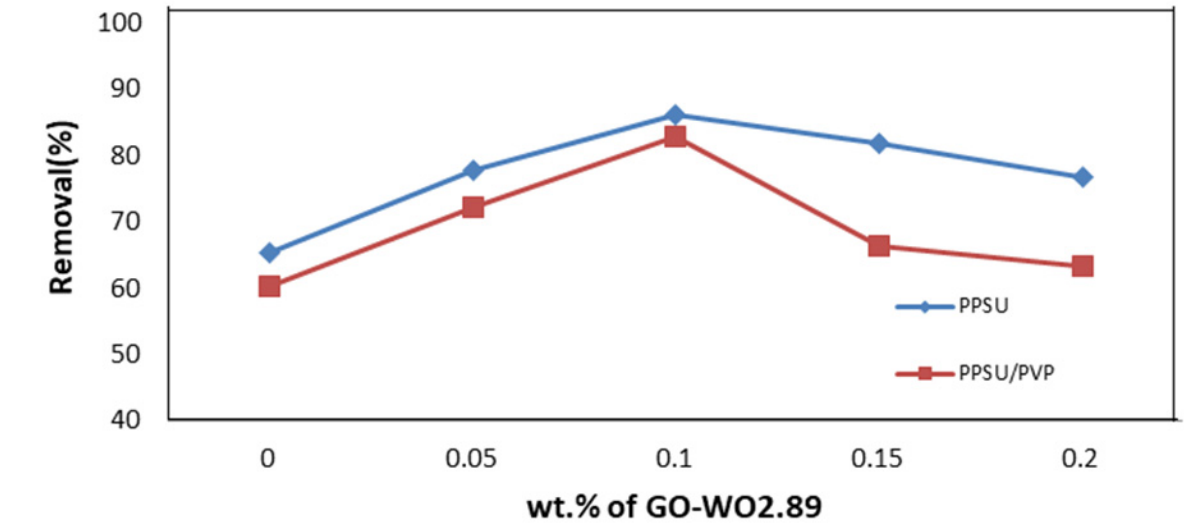
Figure 15. Rejection (R %) for BSA solution by PPSU membrane and PPSU/PVP membrane.